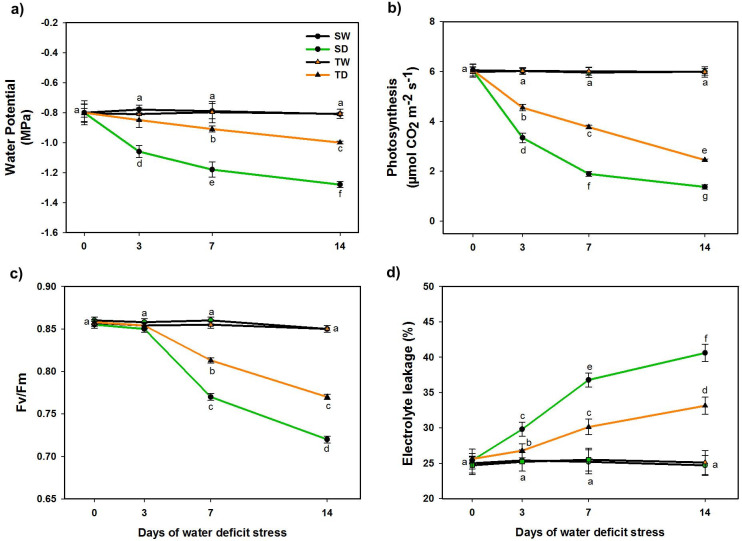
Measurement of physiological parameters in C. papaya plants under well-watered and WDS conditions.Water potential (MPa) (a), Photosynthesis (μmol CO2 m-2 s-1) (b), Fv/Fm (c) and Electrolyte leakage (%) (d) in plants irrigated daily (day 0, well-watered Control plants; SW and TW), and when plants were exposed to WDS for 3, 7 and 14 d.p.t. (SD and TD). Data are means ± SD of 3 replicates (n = 9). Different letters indicate significant differences (p<0.05).